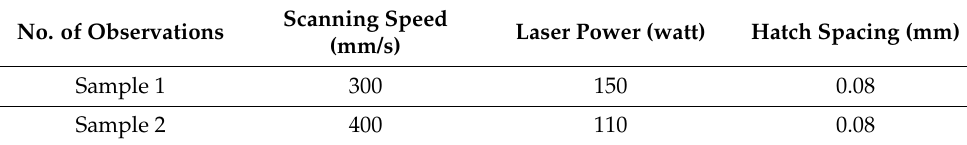
Table 4. SLM parameters for samples selected for electron backscatter diffraction